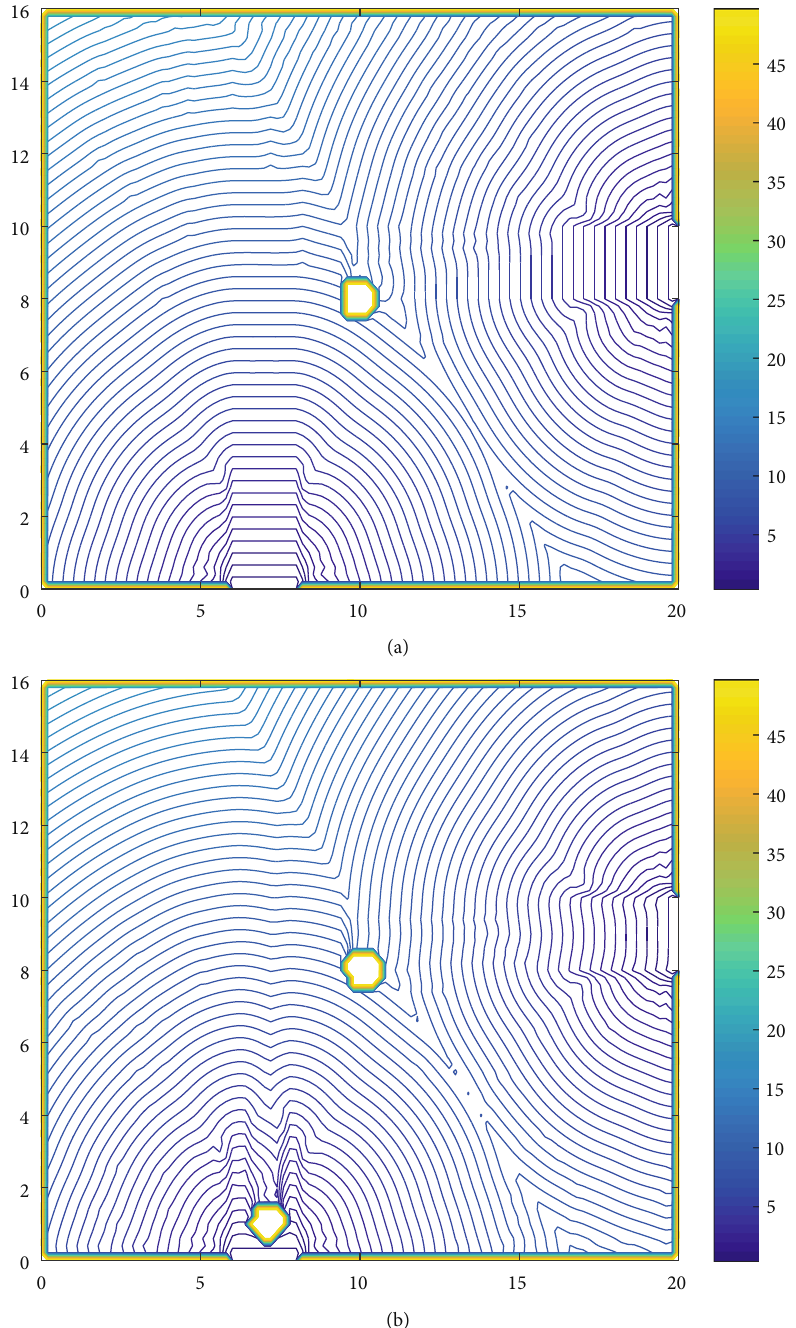
Figure 8: Contour plots of the solution of the Eikonal equation in simulations of 100 pedestrians during propagation of smoke at t =5 s. For a source of smoke, it is located in the middle of the room. Two sources of smoke are placed in the middle of the room and in front of exit 1. The simulation domain is a room with two exits as Figure 3(b). (a) 1 smoke source, t = 5 s. (b) 2 smoke sources, t = 5